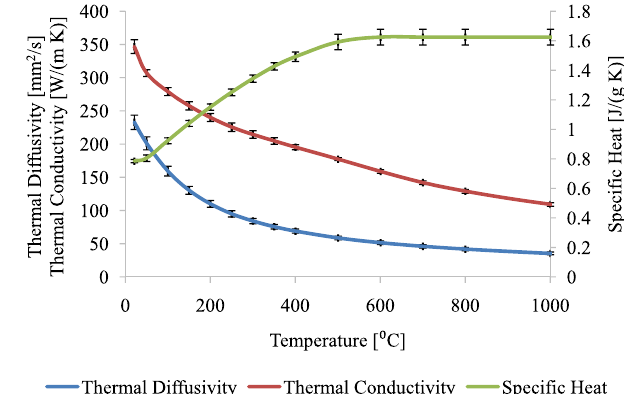
FIG. 4. Plot of thermal diffusivity, thermal conductivity, and specific heat against temperature for CuCD.